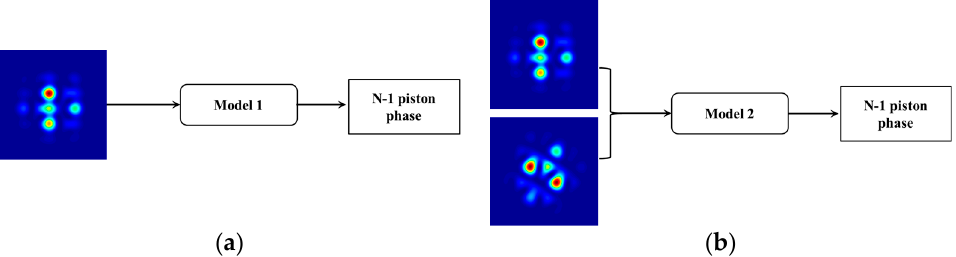
Figure 9. ( a ) Diagram of model 1; ( b ) Diagram of model 2.